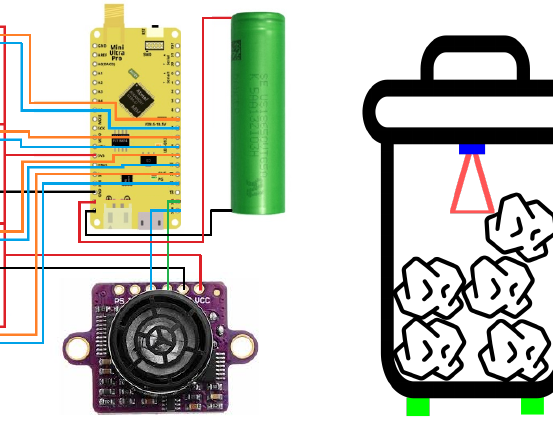
Figure 9. Garbage bin diagrams.